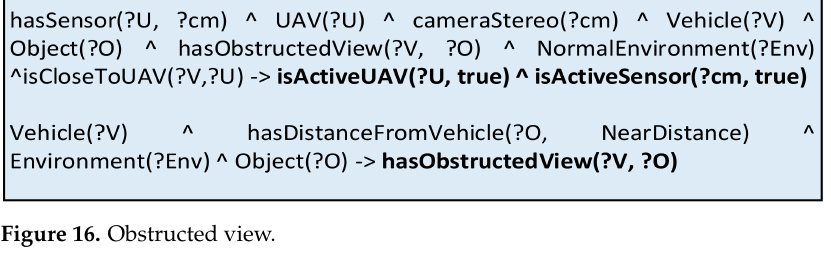
Figure 16. Obstructed view.